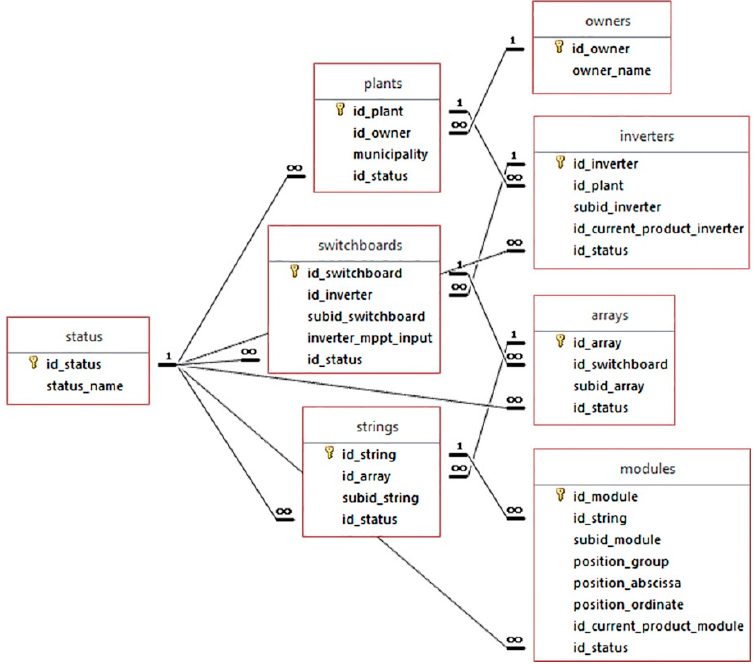
Figure 7. The main group of the conceptual model implemented into the relational database.